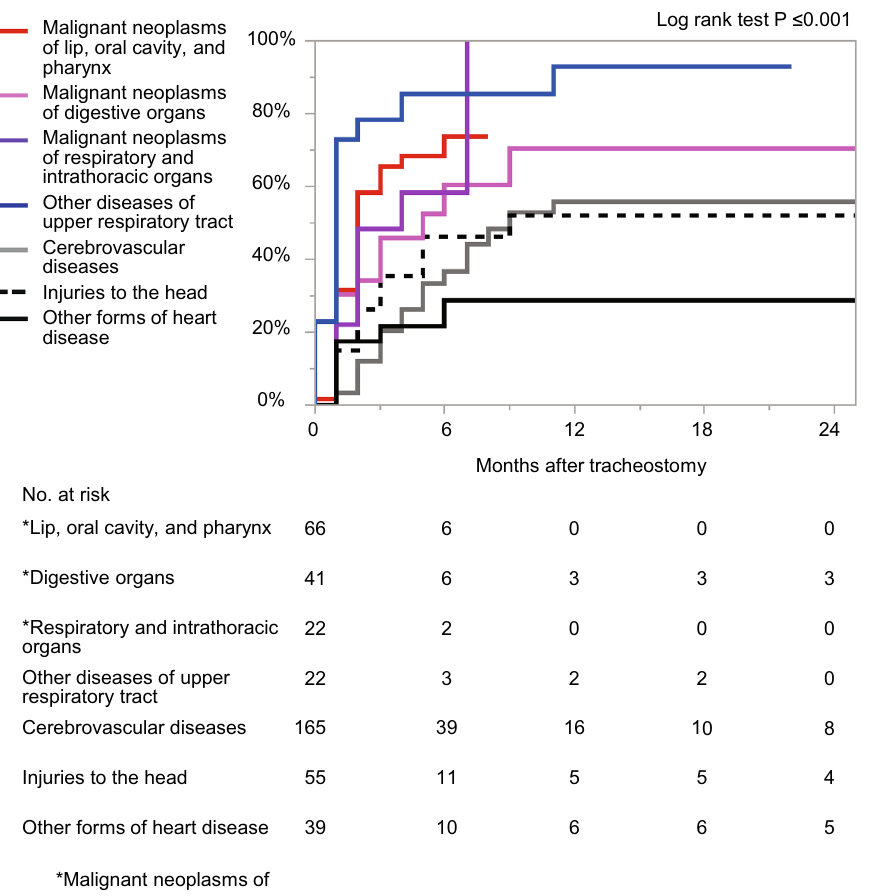
Figure 4. Kaplan–Meier curves for time to decannulation by